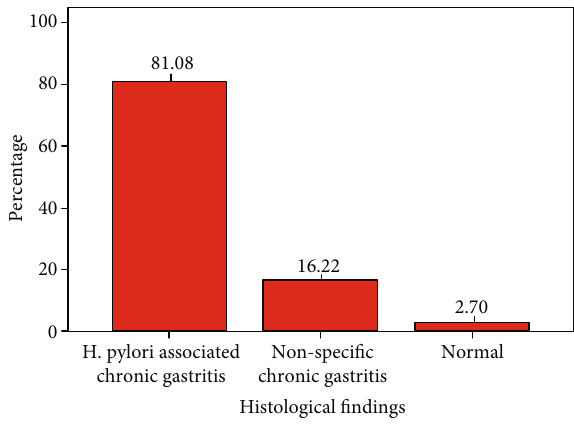
Figure 4: Histological fi ndings in PUD